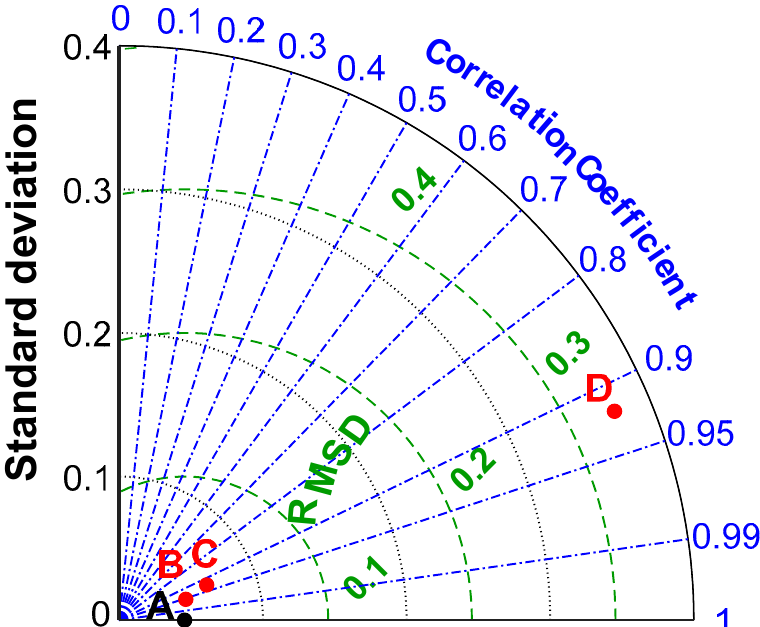
Figure 8. Taylor diagram for the CPSOCGSA-ANN, MPA-ANN, and SMA-ANN prediction models.